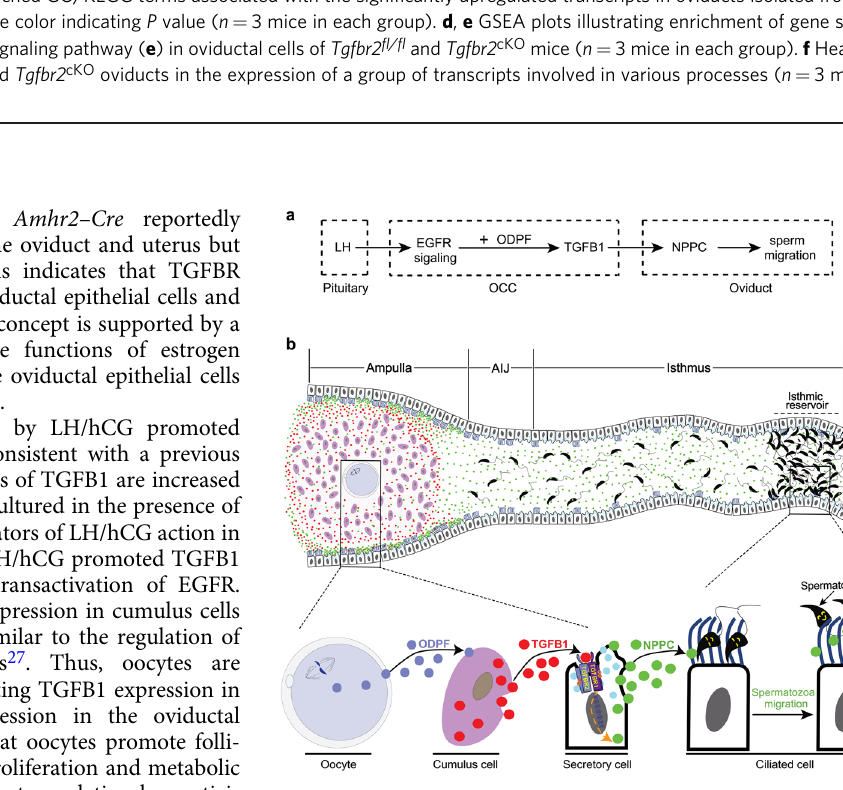
Fig. 6 Schematic showing that cumulus cell-derived TGFB1 promotes NPPC expression in the ampulla for mouse sperm migration in the oviduct. a , b Molecular signaling ( a ) and cellular interaction ( b ) for sperm migration in the oviduct. When ovulation occurs, LH activates EGFR signaling in cumulus cells by EGF-like growth factors, and then cooperates with oocyte-derived paracrine factors (ODPF) to promote cumulus cell TGFB1 expression. TGFB1 induces NPPC production by binding to TGFBRs in the ampullary epithelial cells, and then promotes sperm migration from the isthmic reservoir to the ampulla for fertilization. AIJ, ampullary – isthmic